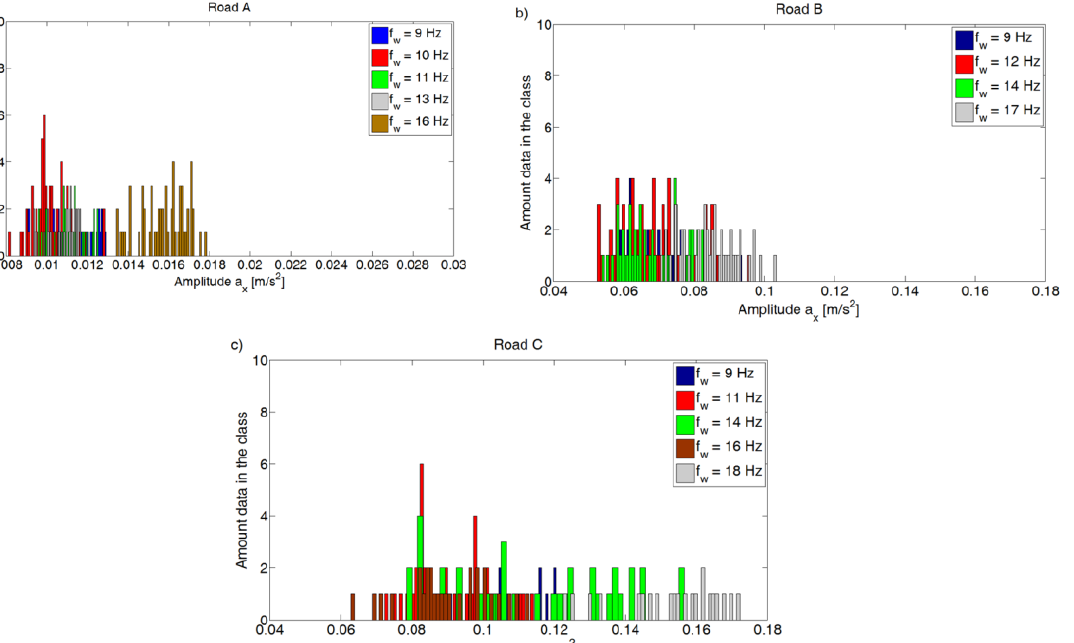
Figure 14. Histogram of variable a x for road surface ( a ) good A, ( b ) slightly damaged B, ( c ) bad C.